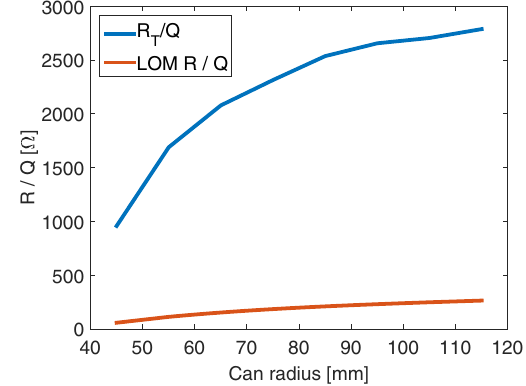
FIG. 11. Plot of the R T = Q (blue) and LOM R/Q (red) vs. radius for the outer